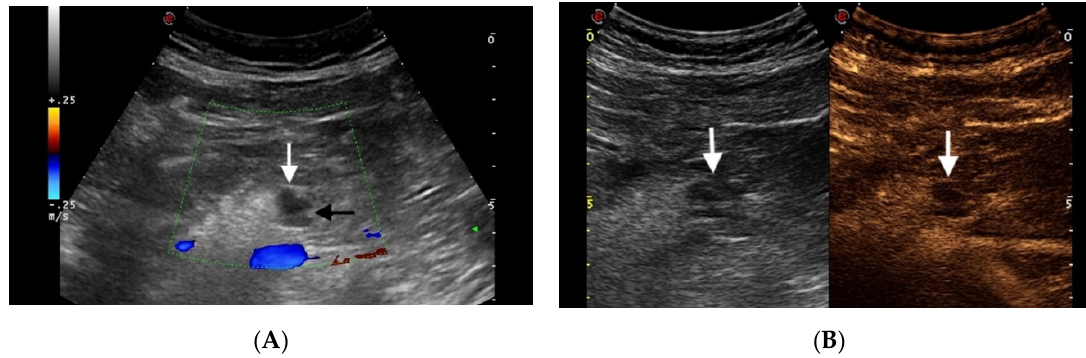
Figure 3. Branch duct IPMN. ( A ) Color Doppler Ultrasonography (dotted box) depicts lack of vascularity within a 1 cm anechoic cystic mass (white arrow) in the pancreatic body. A tiny septum is also appreciable within the lesion (black arrow). ( B ) On CEUS the lesion shows lack of vascularity throughout the different phases, as well as the internal septum (arrows).